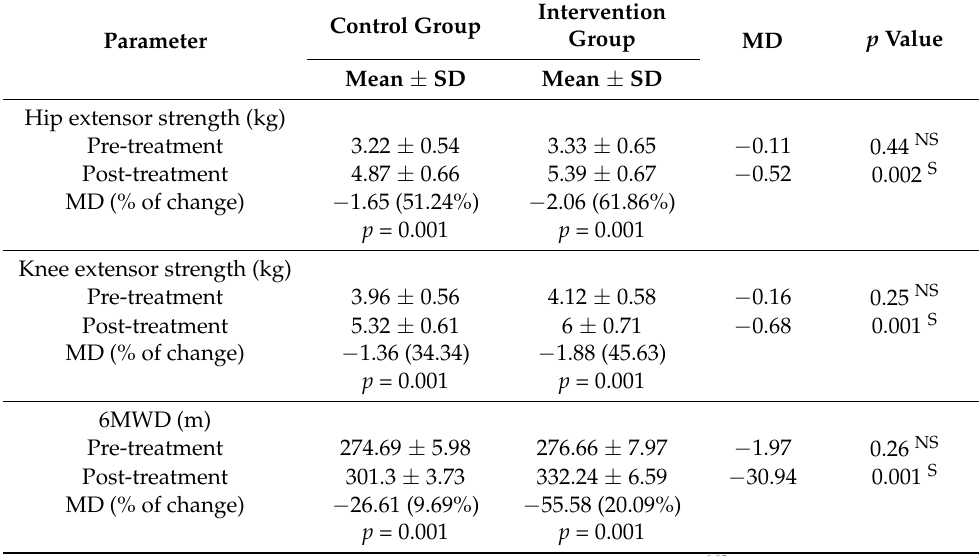
Table 3. Mean values of hip and knee extensors strength and 6MWD pre- and post-treatment of control and intervention